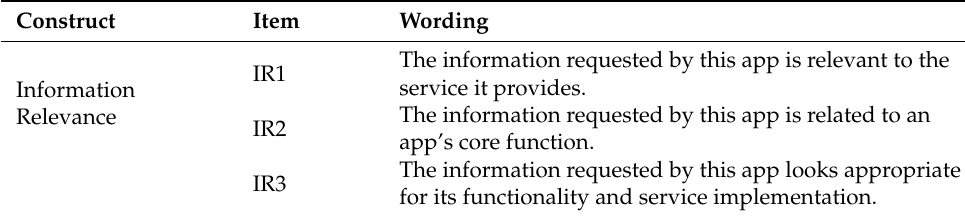
Table A1. The final items and sources of each